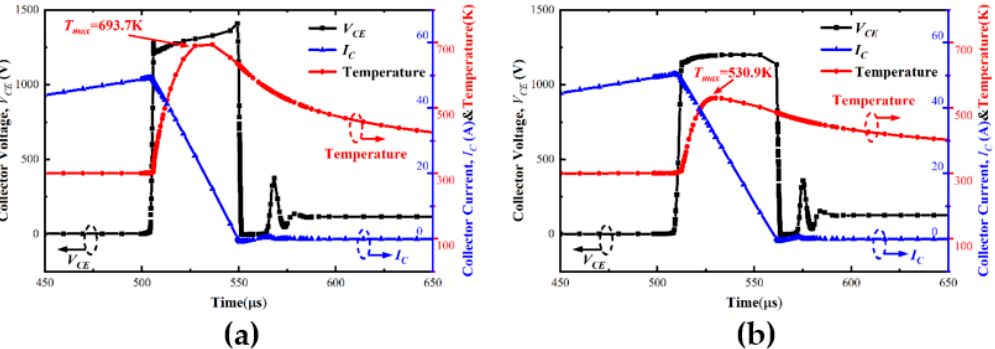
Figure 12. The unclamped inductive switching (UIS) waveforms for ( a ) conventional RC-IGBT and ( b ) the proposed SE RC-IGBT.